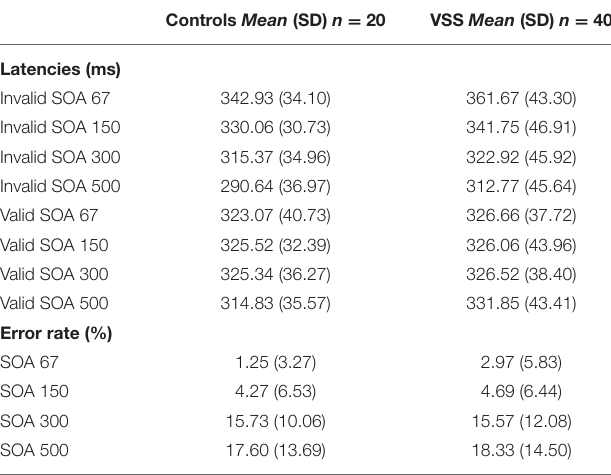
TABLE 3 | Means and standard deviations for ocular motor task